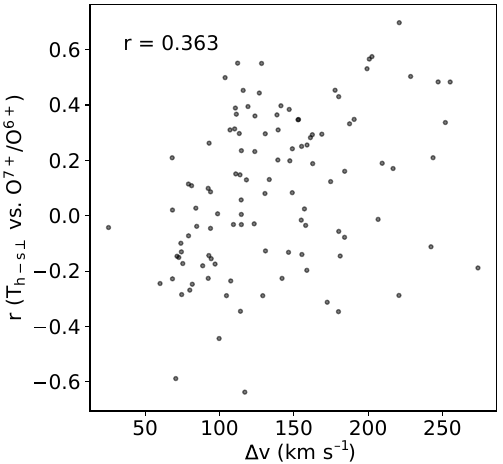
Figure 9. Plot of the correlation coefficient r , calculated between T h–s ⊥ and O 7 + / O 6 + for each Carrington rotation, against the mea- sure of spread in velocity (cid:49)v . There is a weak positive trend be- tween the